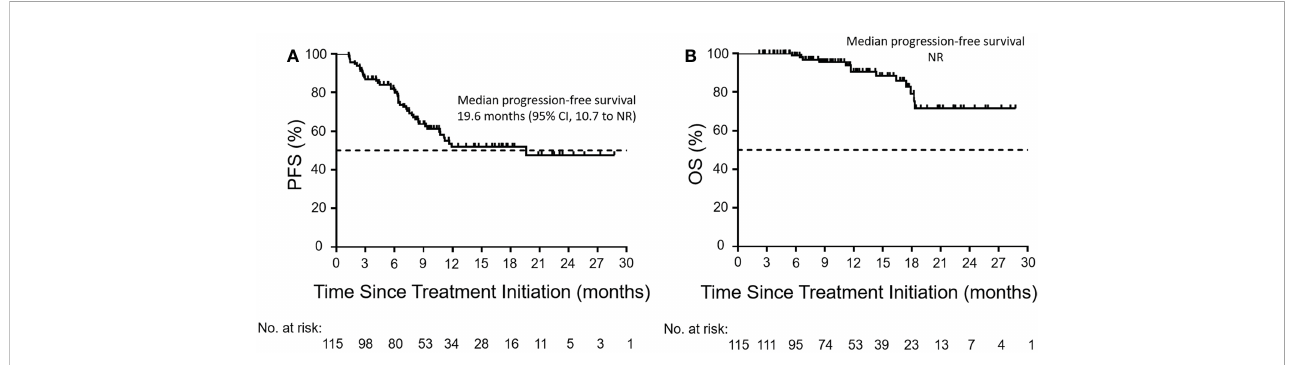
FIGURE 2 Kaplan – Meier curves of PFS and OS. Kaplan – Meier curves of (A) PFS and (B) OS in the enrolled population (n = 115). The Kaplan – Meier analysis was used to plot the survival curves. The dashed line indicates a PFS or OS rate of 50%. PFS, progression-free survival; OS, overall survival; CI, con fi dence interval; NR, not